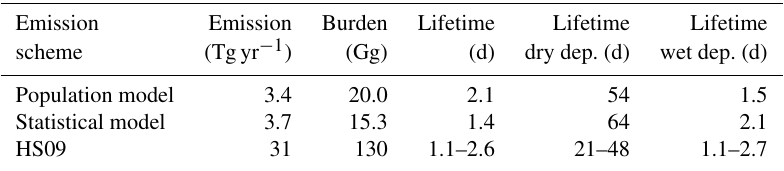
Table 4. Global emissions, burden and lifetime for fungal spores using the three different emission schemes. The different lifetimes for the HS09 scheme are for the coarse and fine modes,